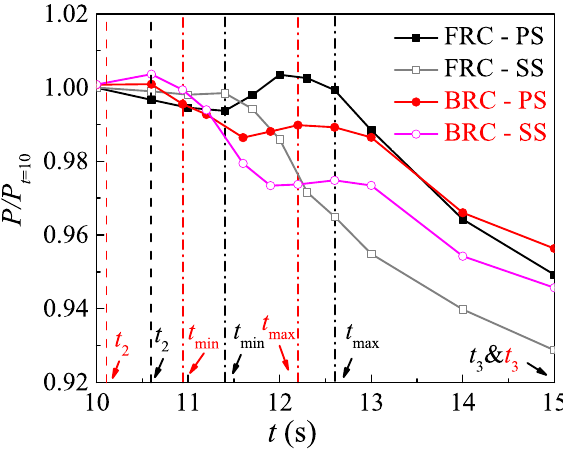
Figure 13. The pressure integral on PS and SS under FRC and